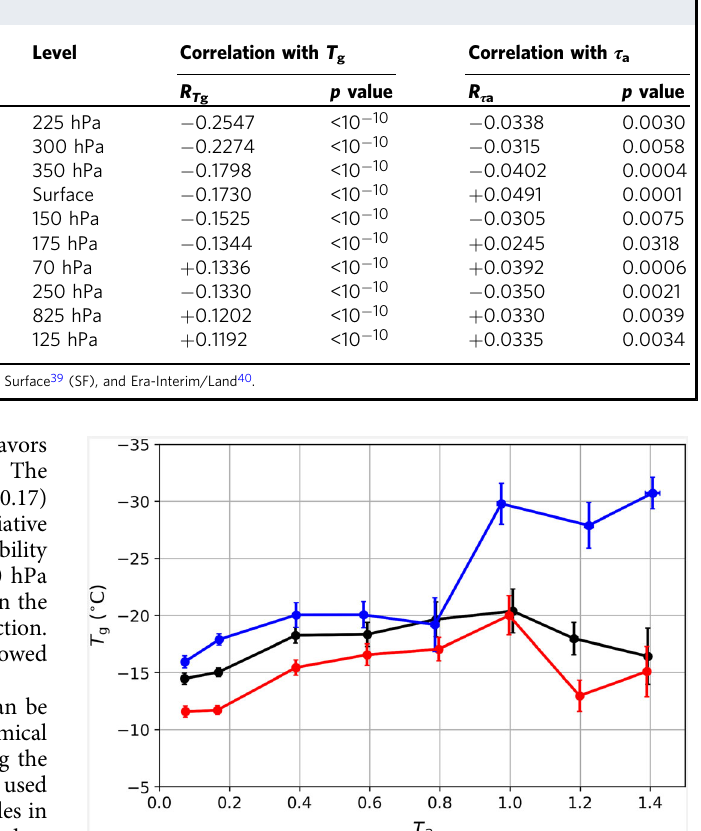
Table 1 Top correlations in the period 2000-2014, between ECMWF reanalysis variables and T g ( R T g ), and between reanalysis variables and τ a ( R τ a ).